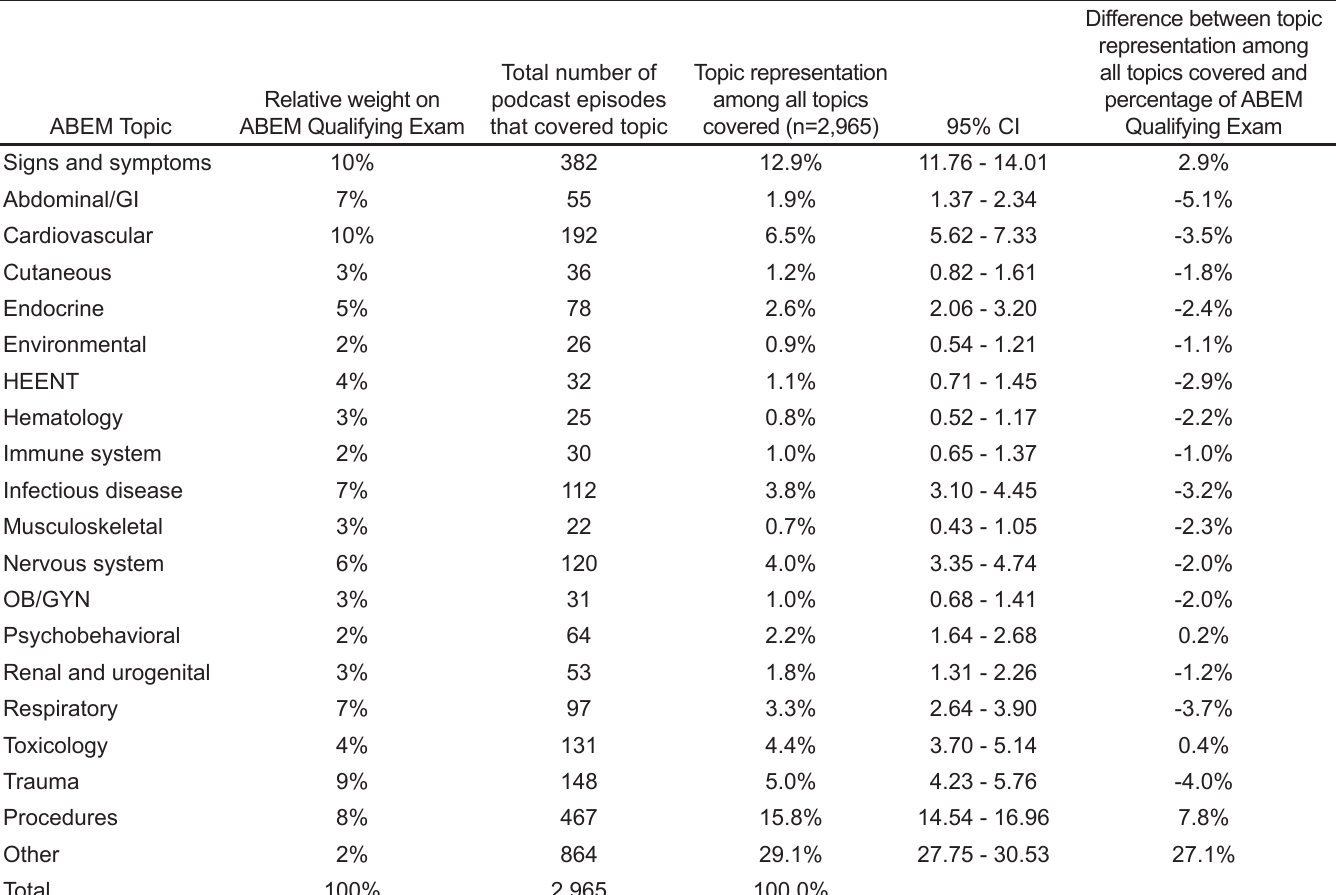
Table 1. Proportional representation of the American Board of Emergency Medicine EM Model topics covered in podcasts relative to the ABEM Qualifying Exam.